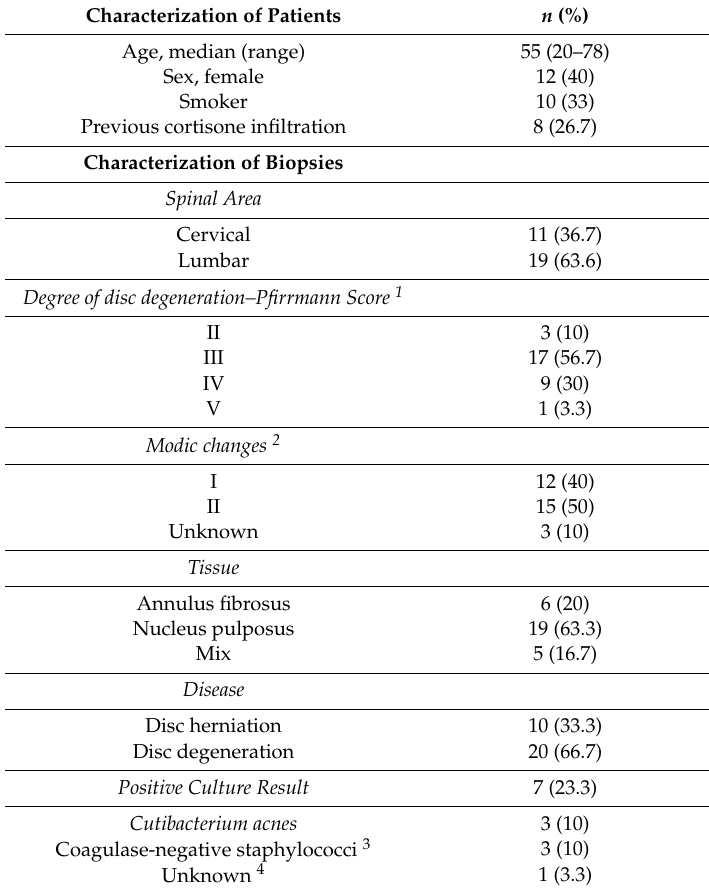
Table 1. Characterization of 30 patients undergoing spinal